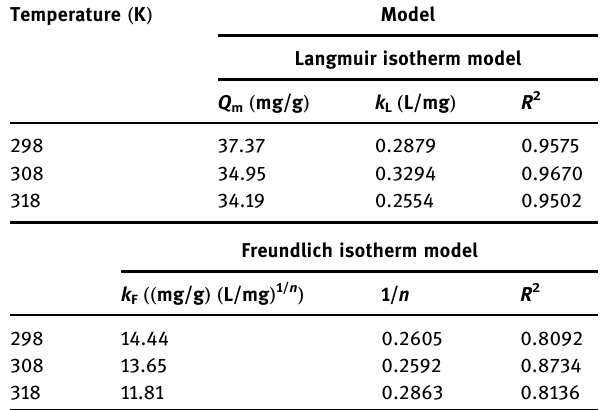
Table 2: Langmuir, together with Freundlich isotherm model para - meter within the HM ion system at varying temperature